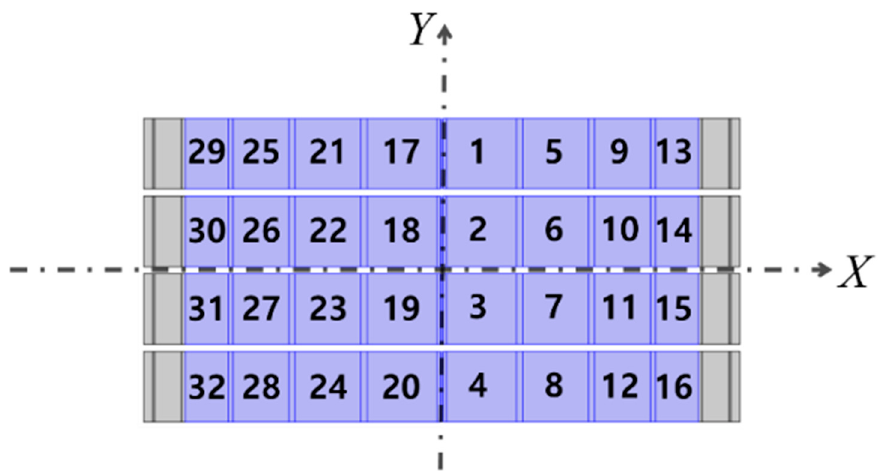
Figure 7. Transducer number (front view).